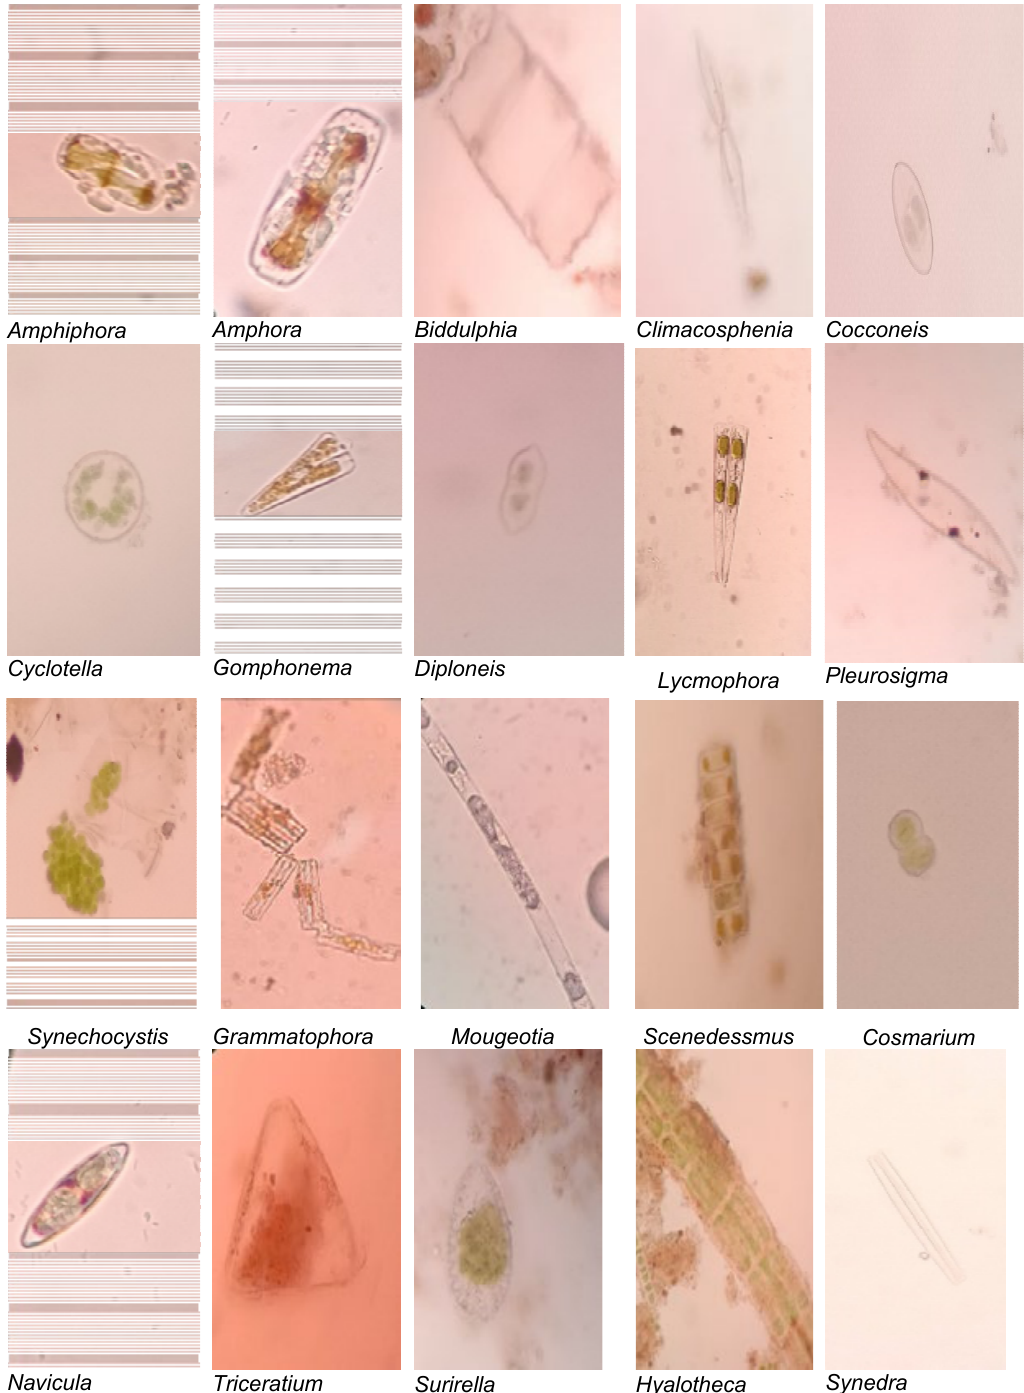
Fig. 2a: Several microalgae found in Siwil Beach (magnification 4x10)